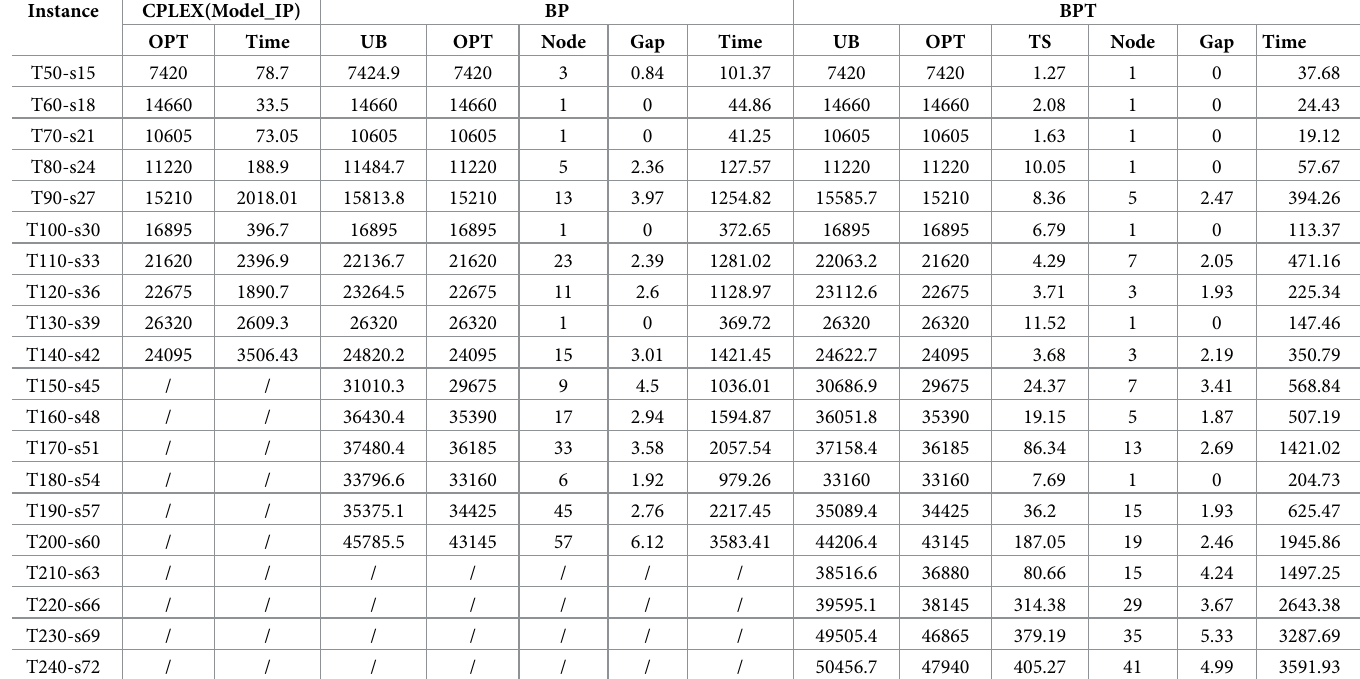
Table 6. Computational results for large-sized